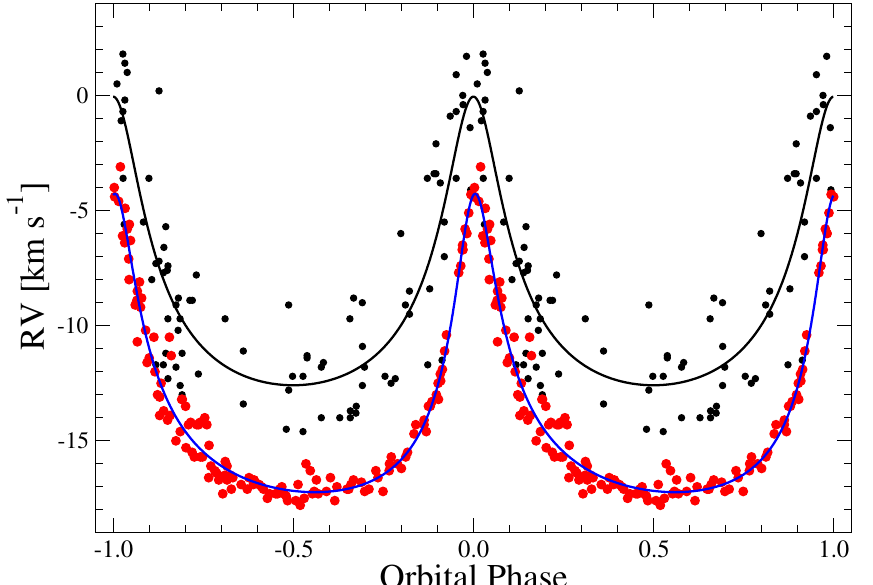
Figure 2. RV curves of MizarB derived by Gutmann [5] and in this paper. The DAO data are shown by black dots, and the best fit to these data is shown by the black solid line. The TCO data are shown in red, and the best fit is shown by the blue solid line. The RVs are heliocentric.